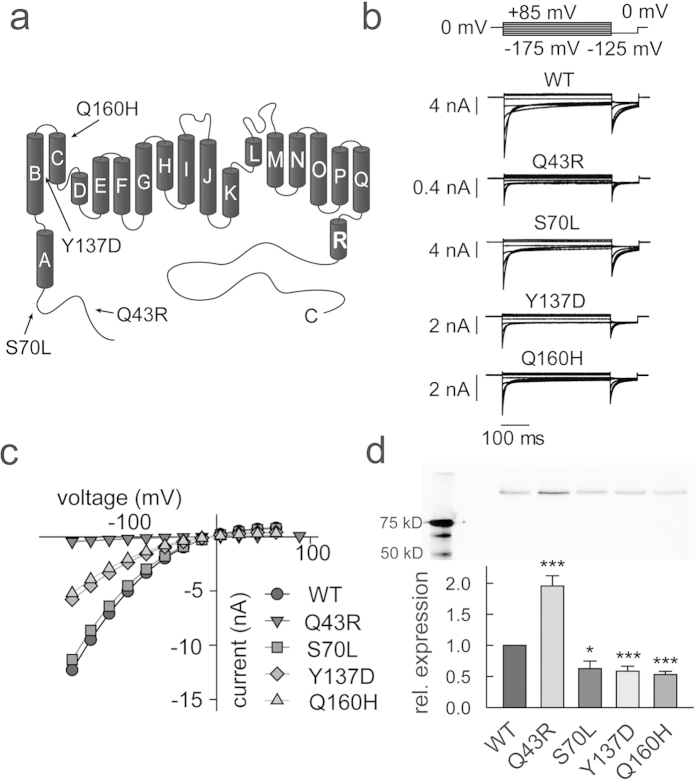
Myotonia-associated mutations modify mean current amplitudes in heterologous expression system without reducing protein expression levels.(a) Location of the tested mutations in a topology model of the chloride channel protein modified from Dutzler et al.5 (b) Representative currents of WT and mutant hClC-1 recorded under symmetric chloride conditions. (c) Voltage dependence of mean instantaneous current amplitudes (means ± SEM from 6–18 experiments). (d) Relative expression levels of WT and mutant hClC-1 channels given from relative fluorescent values (lower panel, means ± SEM from 5 experiments) and representative fluorescence scan of a SDS-PAGE gel of YFP-tagged WT and mutant hClC-1 channels in the total cleared lysate of cells that were transfected with equal amounts of plasmid DNA. The expected molecular mass of mYFP-hClC-1 is 136 kDa. In each experiment lysate samples were adjusted to equal total protein amounts before loading the gel. (Student’s two-tailed t-test with *p < 0.05 and ***p < 0.001).